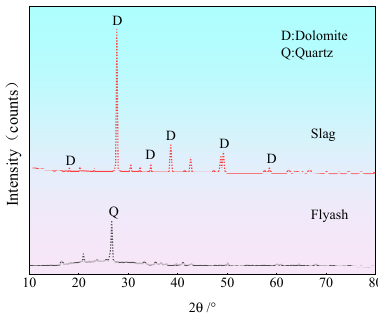
Table 4. Physical property index of blast furnace slag.